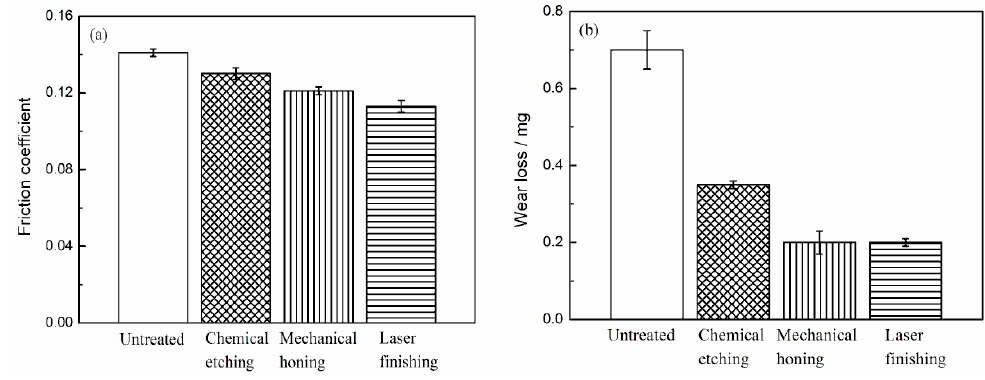
ffi cient ( a ) and wear loss ( b Figure 14. Friction coefficient ( a ) and wear loss ( b ). Figure 14. Friction coe Figure 14. Friction coefficient ( a ) and wear loss ( b ).